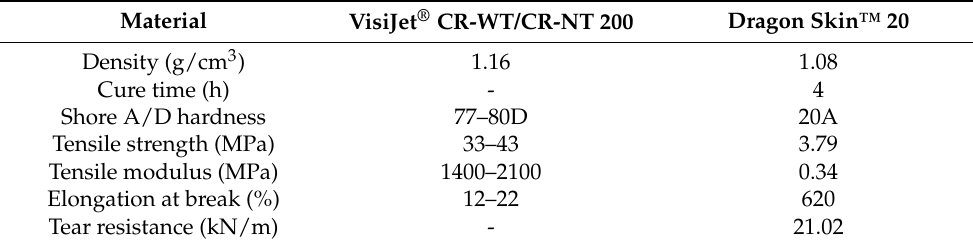
Table 1. Physical and mechanical properties of the Dragon Skin™ 20 the VisiJet ® materials.